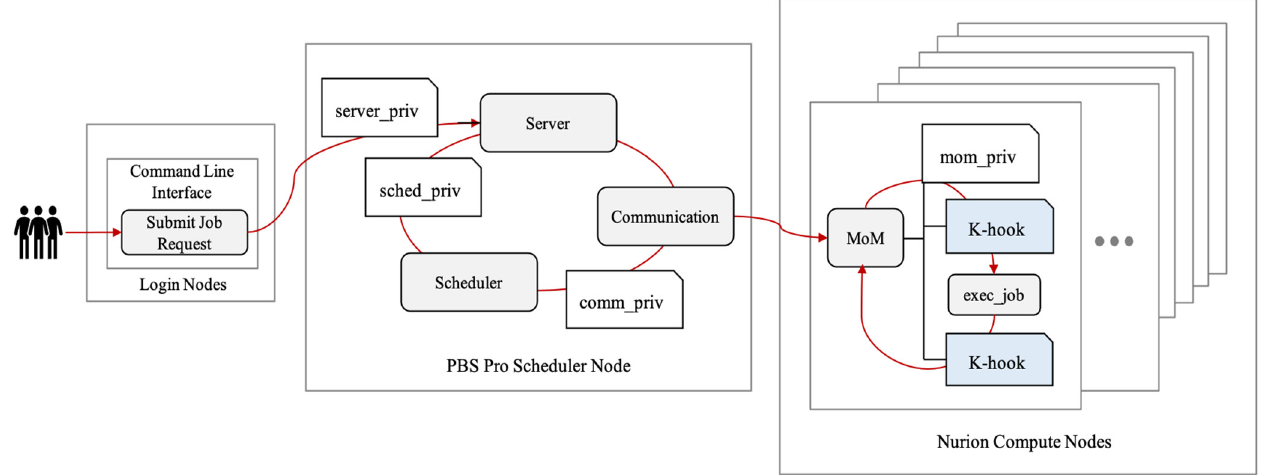
Figure 3. An overall workflow of scheduling with K-hook.